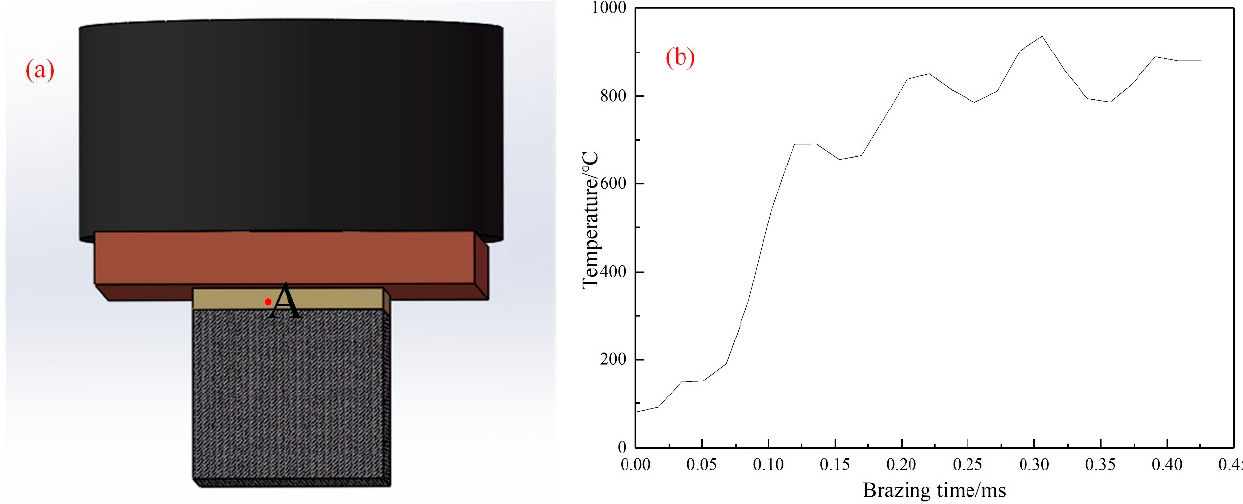
Figure 12. XRD results of the fracture surface of the welded joints: ( a ) C/C side, ( b ) Cu side. Figure 13 depicts the interface temperature between C/C composites and T2-copper with the second section of welding parameters in Table 2 measured by the infrared thermal imaging camera. It was found that the initial temperature of the surface temperature at the interface between C/C composites and T2-copper reached 180 ◦ C. This was attributed to the resistance heat generated in the first stage with the welding parameters (welding current of 5 kA, welding time of 30 ms, and welding pressure of 0.01 MPa). Meanwhile, filler metal at the interface would be softened and the tiny plastic deformation therefore occurred under the function of temperature and pressure. As a result, the contact area between the filler metal and base metal on both sides was increased, and then the resistance at the interface was decreased according to Equation (2), which provided a condition and preparation for the second section of welding parameters to heat the filler metal. Subsequently, the maximum temperature of the surface increased to 948.9 ◦ C in the second stage, as shown in Figure 13b. Generally, the welding nugget was generated inside the workpiece due to the instantaneous resistance heat in the traditional resistance welding process, meaning that the internal temperature of the workpiece was higher than the surface temperature. Therefore, the internal temperature of the workpiece may reach the melting point of the element from Cu parent metal diffusion to the interface increased, resulting in the increase of the content of Cu at the interface in Tables 3 and 4, too.